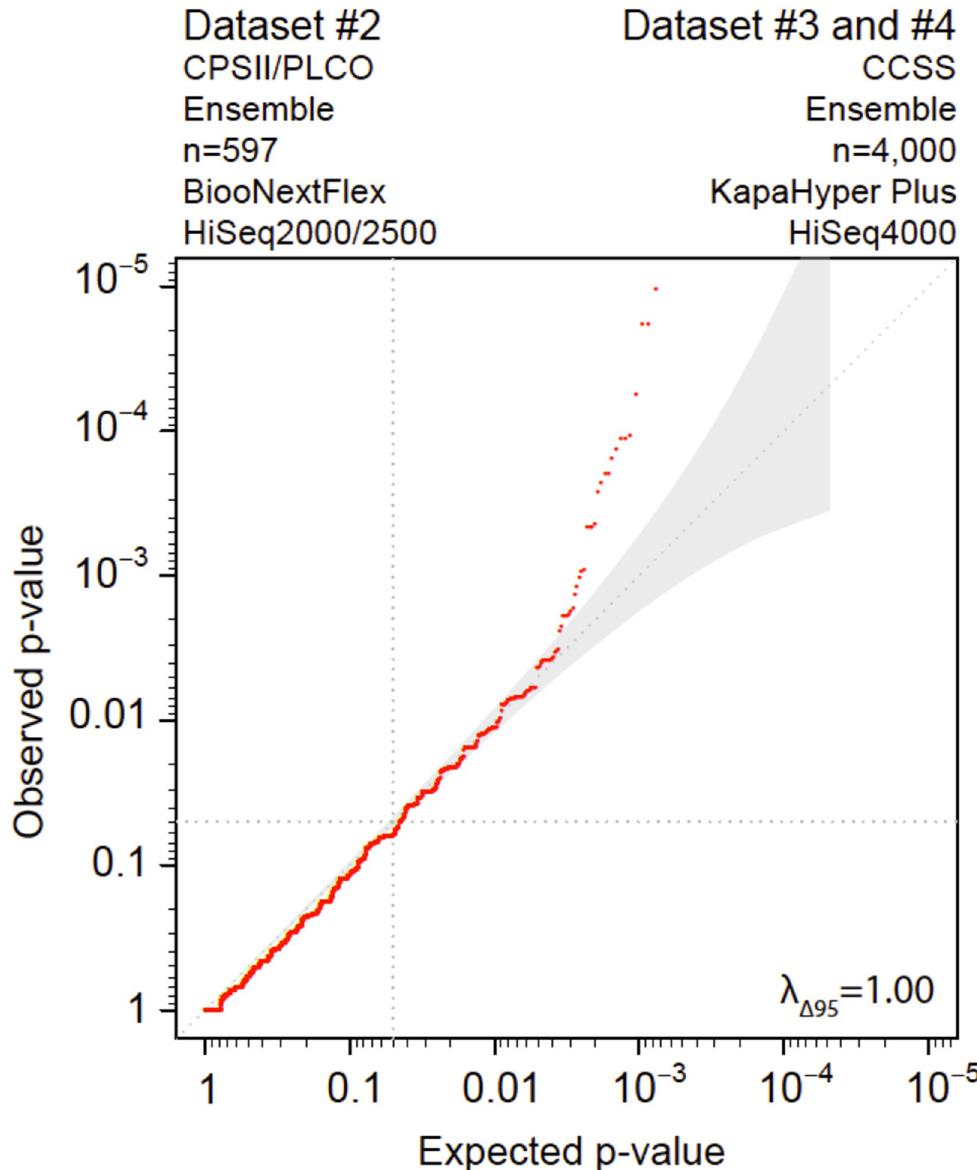
Fig 2. Evaluation of laboratory factors contributing to elevated false-positive findings. Quantile-Quantile plot of two experimental datasets (sub-sampled CCSS data) that used the same capture kit (EZ Exome+UTR PE) and differ in the use of library prep kit (BiooNextFlex vs. KapaHyper Plus) and sequencer (HiSeq 2000/2500 vs. HiSeq 4000). Variants in both cohorts were called using HaplotypeCaller and UnifiedGenotyper and/or